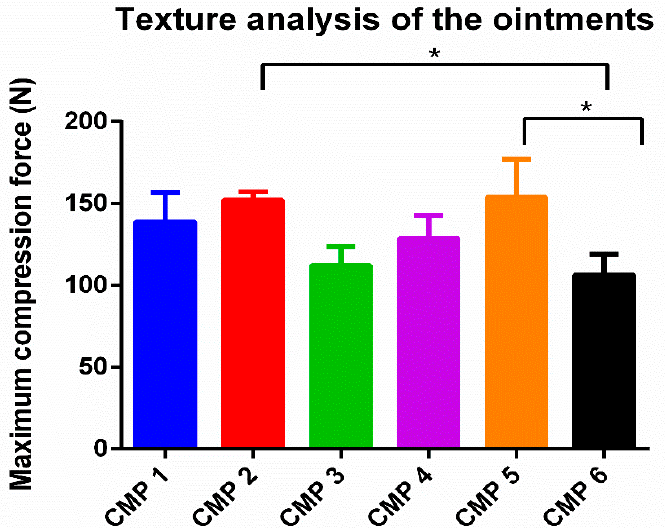
Figure 5. Results of texture-analysis studies. Resistance of the different ointments with the different surfactants. CMP 2 and 5 showed the hardest consistency, CMP 3 and 6 showed the softest consistency. Data are expressed as means ± SD; n = 5. To compare the preparations, ordinary one- way ANOVA test was carried out. Significant differences are marked in the figure with asterisks.